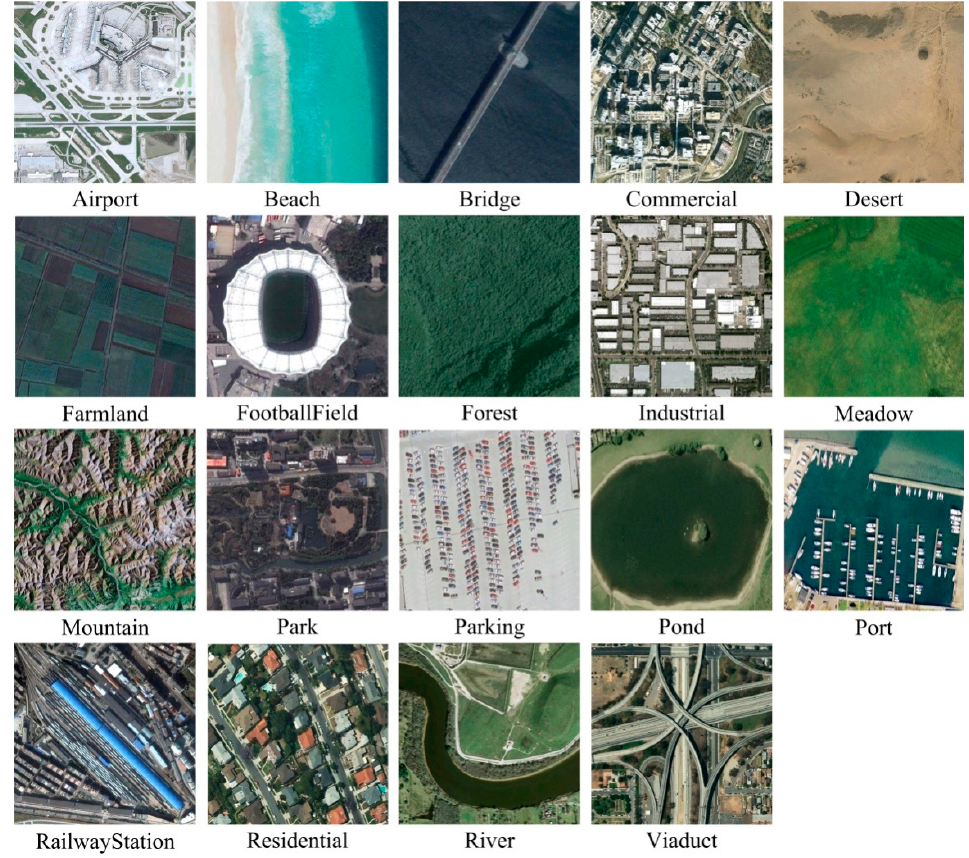
Figure 11. Some sample images of the adopted WH dataset.